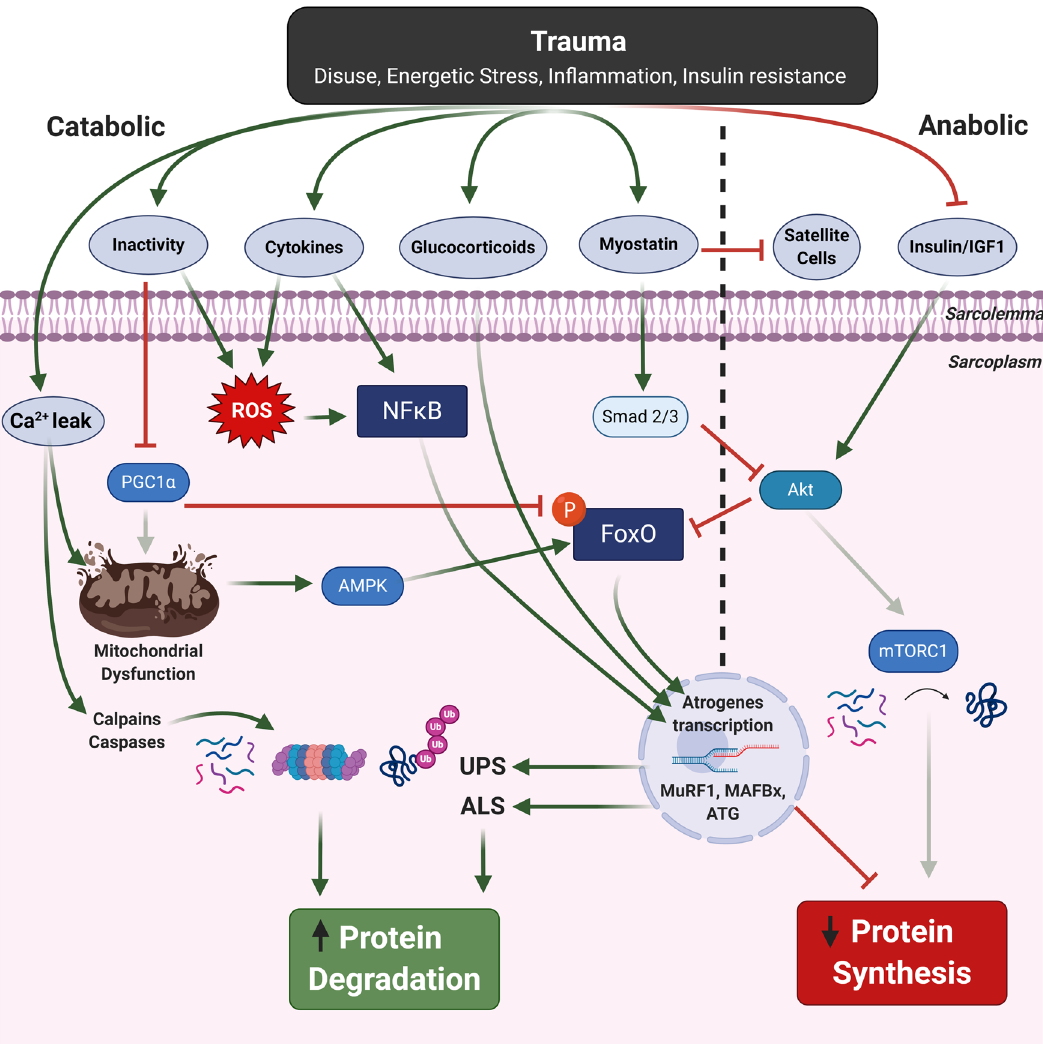
Fig. 3 Potential molecular mechanisms mediating muscle atrophy following ballistic trauma. Trauma is associated with various alterations, such as disuse and in fl ammation, which can induce muscle wasting through various signalling pathways that act to elevate protein degradation (catabolic) and suppress protein synthesis (anabolic). Two key transcription factors regulating muscle atrophy are FoxO and NF- kb, which are activated by numerous upstream factors to promote increases in proteolysis that include the proteasome and